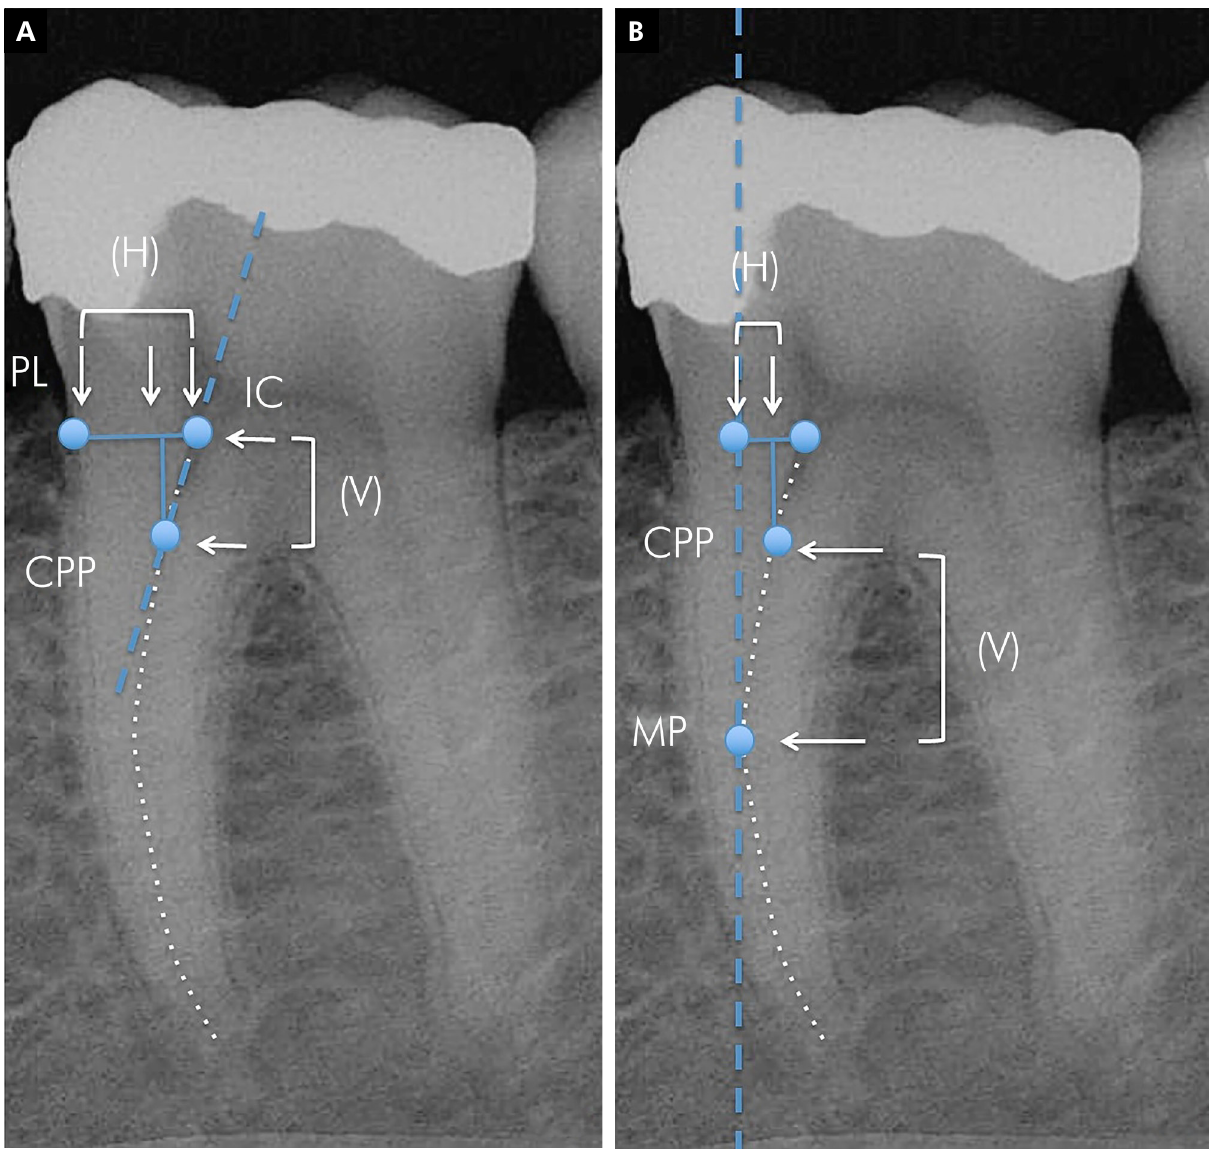
Figure 2. Measurements of the distances between the points: (A) IC-CPP and IC-PL and (B) IC-MP and CPP-MP, in vertical (V) and horizontal (H)